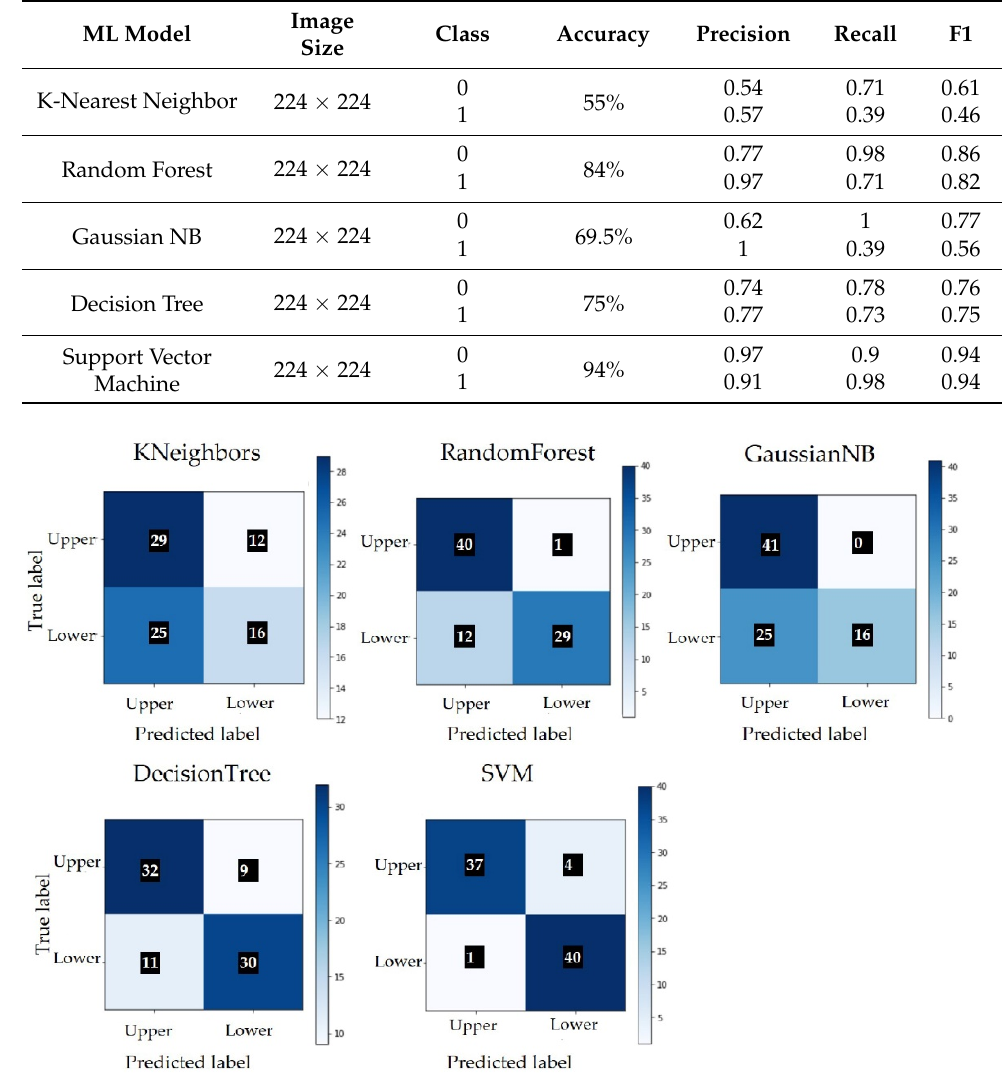
Figure 8. Confusion matrix without normalization.